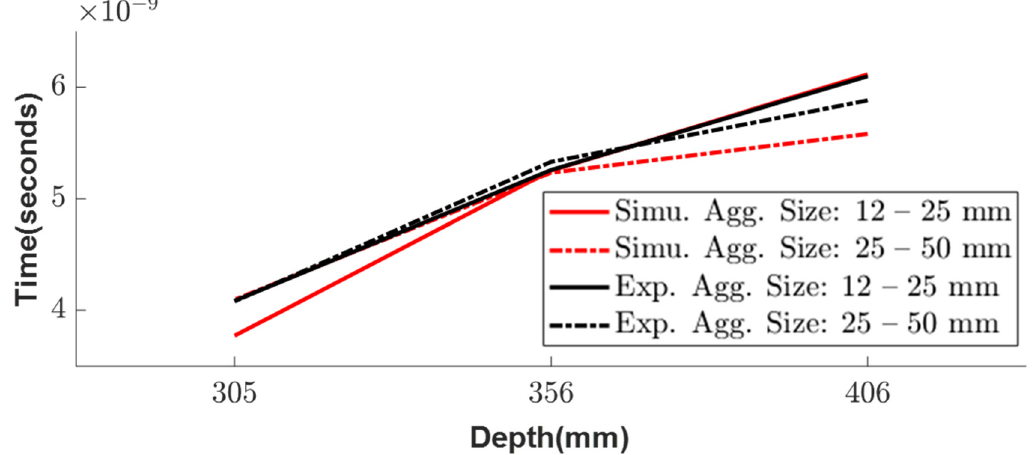
Figure 15. Comparison of time variations at different depths between simulation and experiment depth.